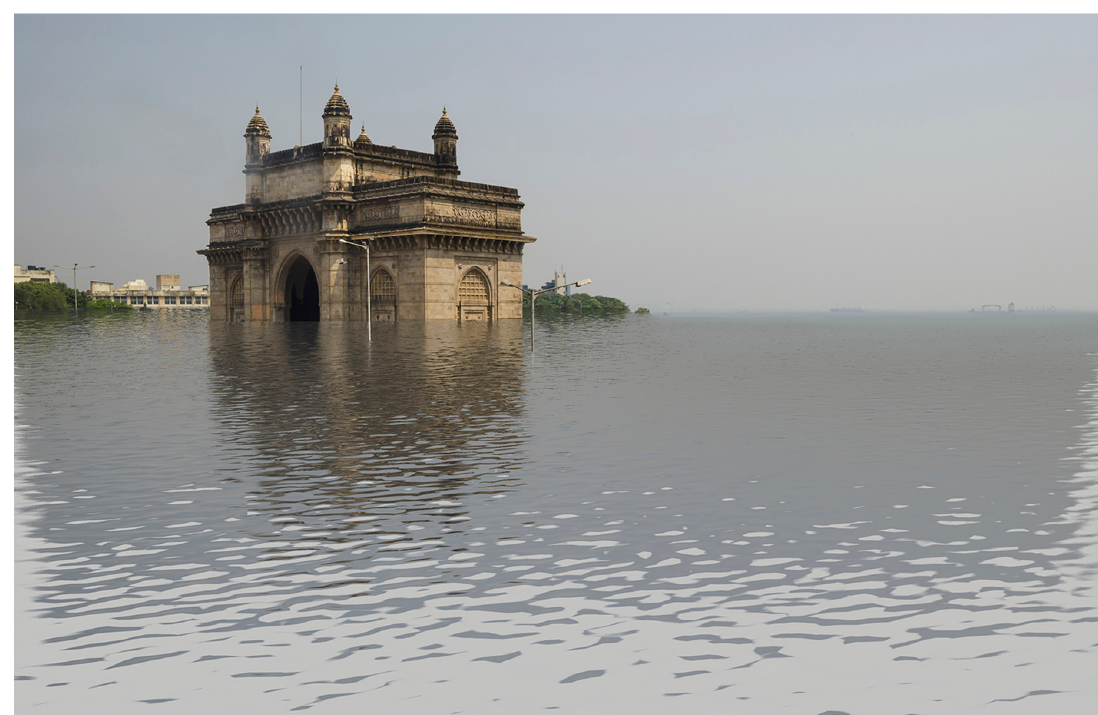
Figure 5. Climate Central’s image of Mumbai at 4 °C of warming.